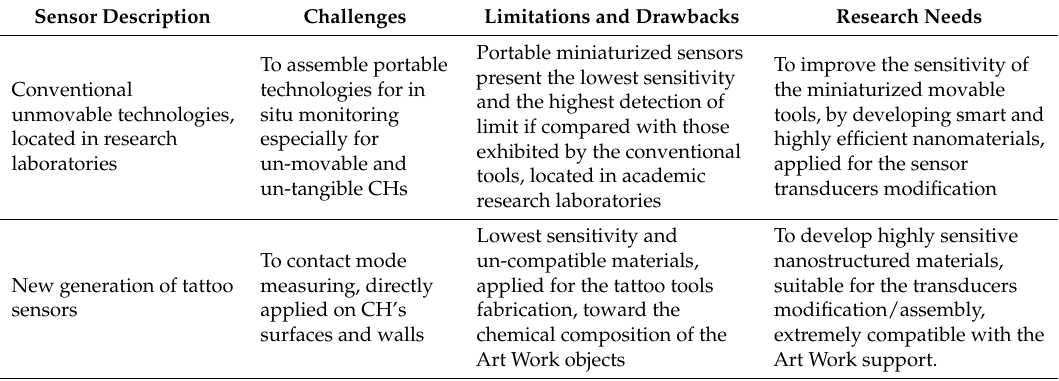
Table 1. Summary of the main challenges, research needs, limitation and drawbacks of the CH